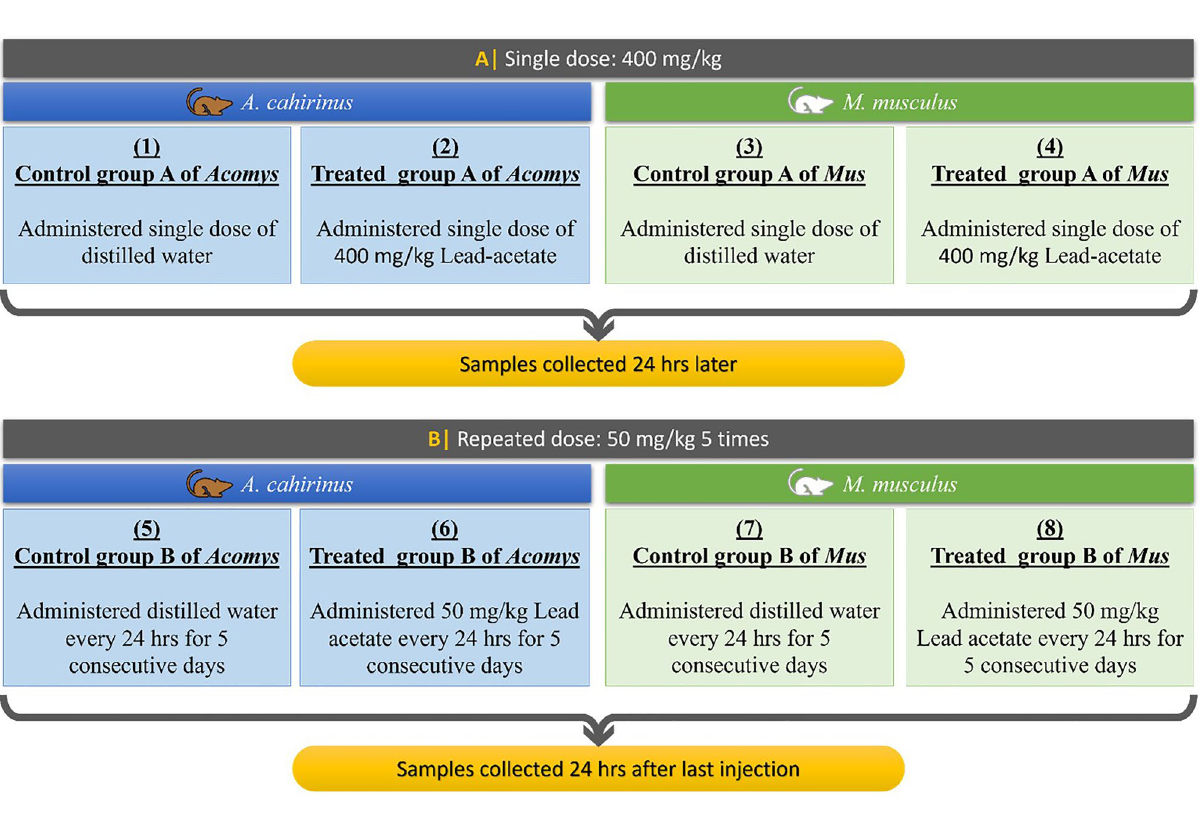
Figure 8. Experimental groups and the study